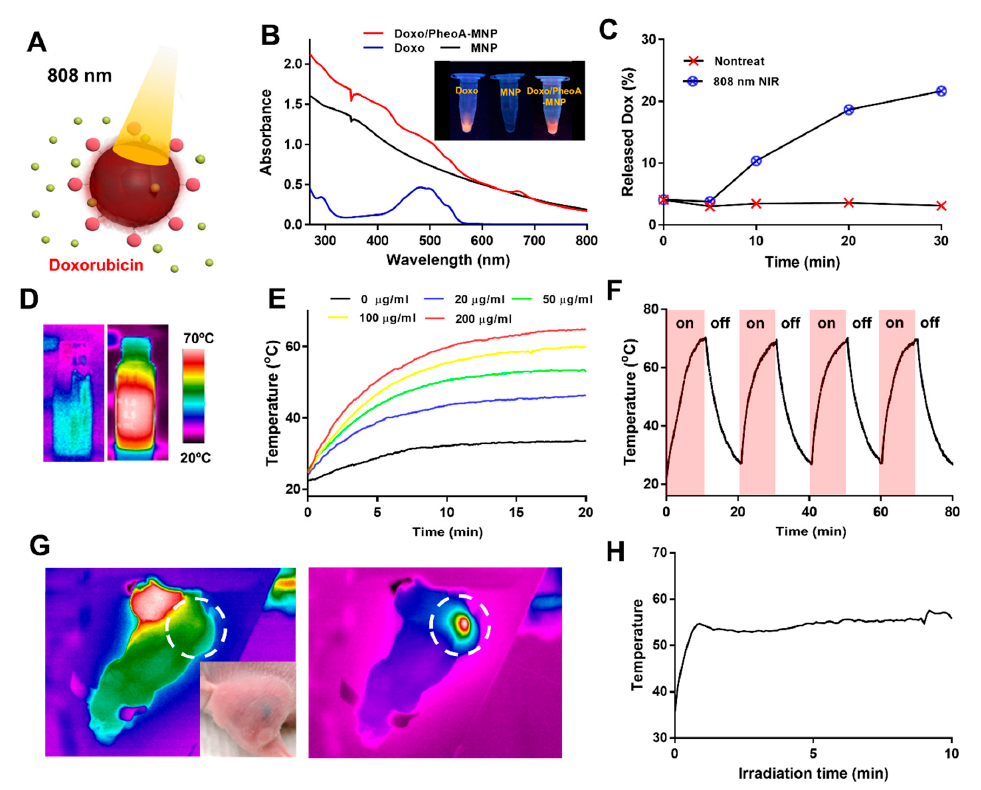
Figure 2. ( A ) Illustration of the stimuli responsive drug release from Doxo/PheoA-MNPs under near- infrared (NIR) irradiation (red ball = Pheophorbide A, green ball = Doxorubicin). ( B ) UV-Vis spectra of MNPs (black), PheoA-MNPs (red) and free Doxo (blue). ( C ) The cumulative drug release from Doxo/PheoA-MNPs triggered by NIR irradiation at a power density of 2 W/cm 2 for different times in phosphate-buffered saline (PBS) (pH 7.4). ( D ) Thermal images of MNP aqueous solution during (left) ON and (right) OFF cycles. ( E ) Temperature change of MNP solutions with varying concentrations (0–200 μ g/mL) for a period of 20 min under exposure of 808 nm NIR light (1.2 W/cm 2 ). ( F ) Temperature evaluation of MNPs over four laser ON/OFF cycles (laser ON time: 10 min, laser OFF time: 10 min). ( G ) Thermal images of tumor-bearing mouse that was exposed to laser irradiation at 808 nm (white dotted circle indicates tumor area) and (H) the local temperature change of the MNPs in the tumor.